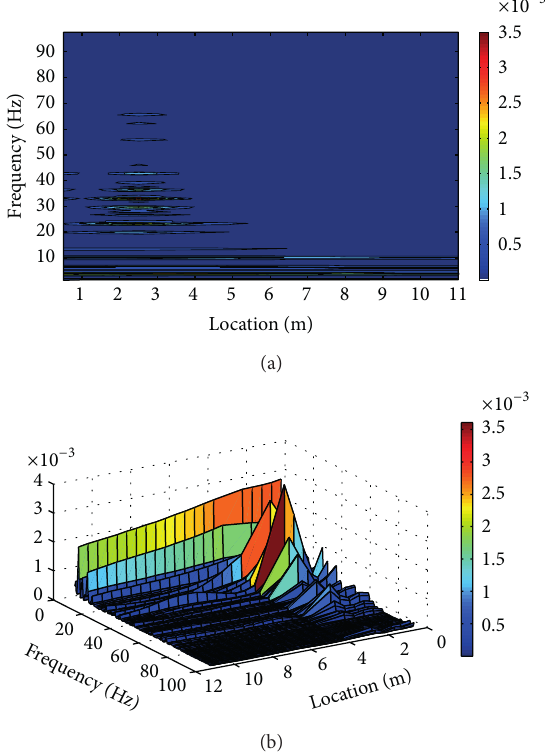
Figure 10: Location-frequency figure with an open trench of 𝐿 = 10m, 𝑊 = 1m, and 𝐻 = 3 m (a) contour plot of displacement spectrum on ground surface and (b) surface plot of displacement spectrum on ground surface (Poisson’s ratio ] = 0.45, train speed 𝑉 = 300 km/h). Note: the location coordinate of trench is from 2.5 to 3.5